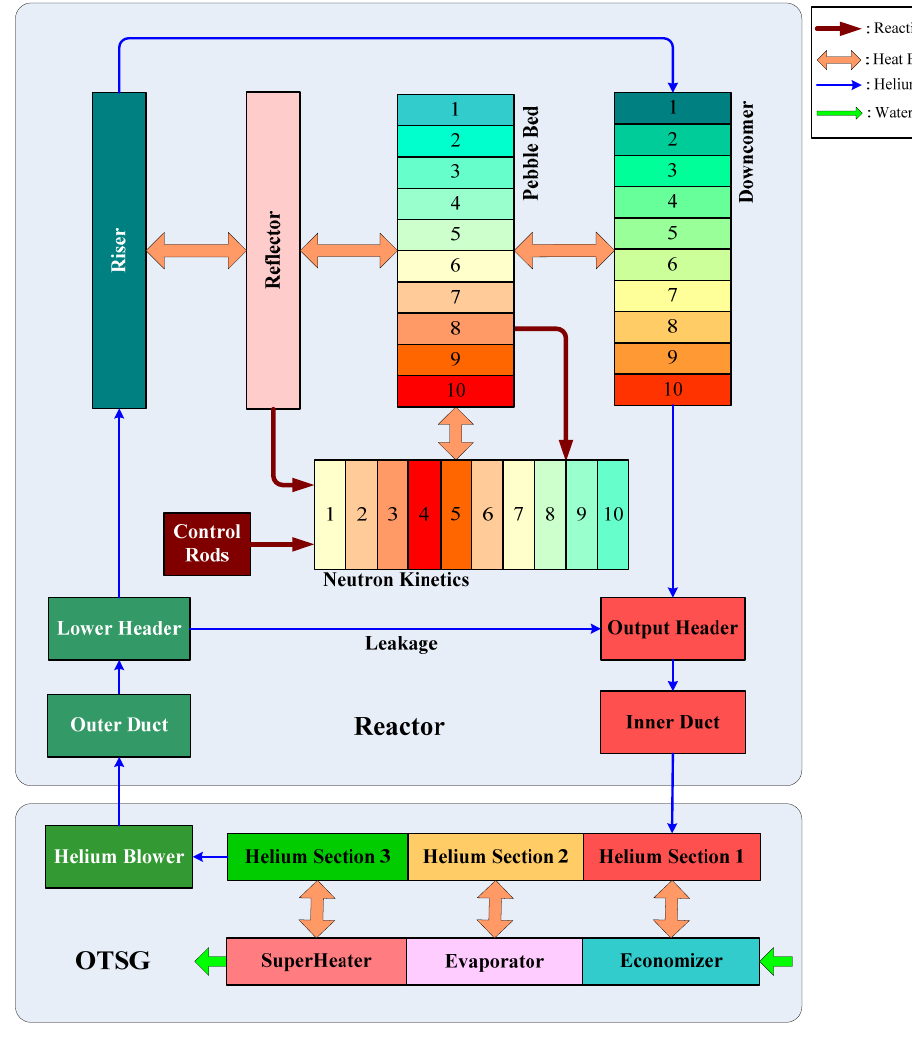
Figure 2. Nodalization for the NSSS of the